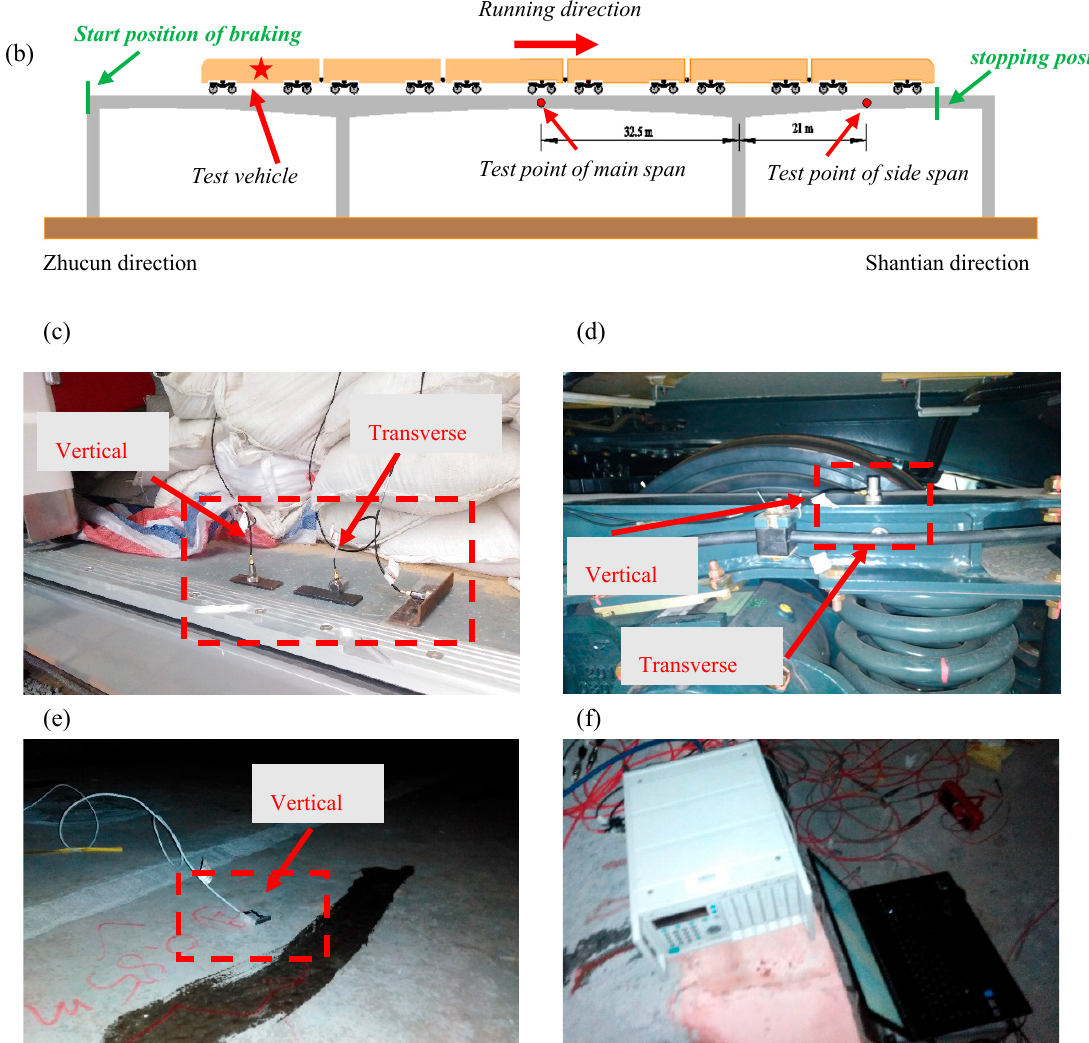
Figure 2. Field test set-up: ( a ) schematic diagram of the box girder; ( b ) schematic diagram of the experiment; ( c ) measurement points on the train body; ( d ) measurement points on the bogie frames; ( e ) measurement points on the bridge; ( f ) the HBM data collection system.